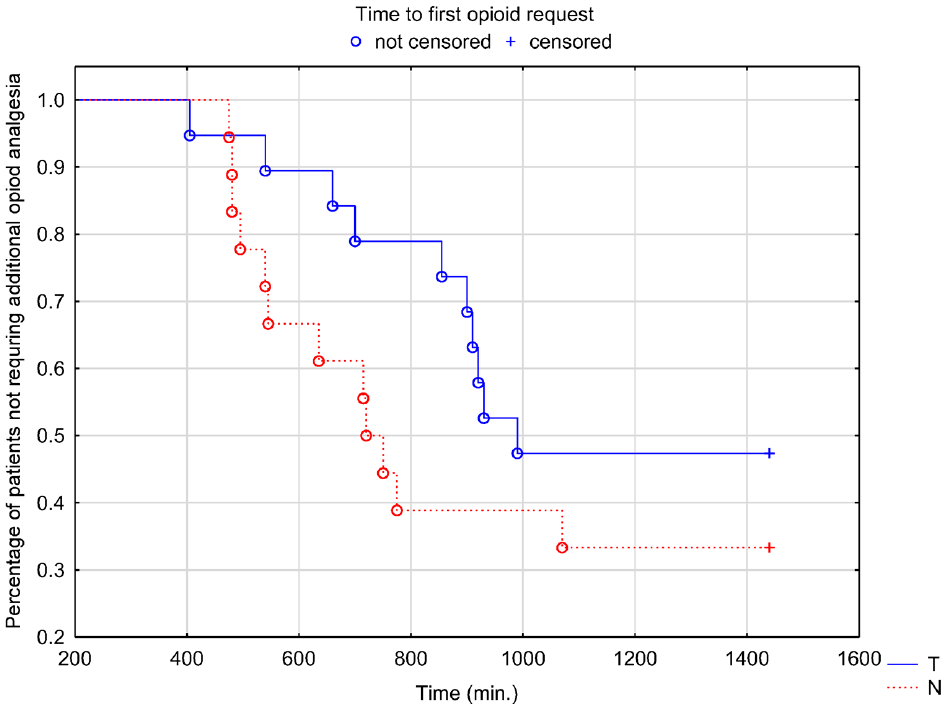
Figure 3. Kaplan–Meier plot of time to first requested opioid for NRS > 3. Blue line (T): tramadol group. Red line (N): control group.